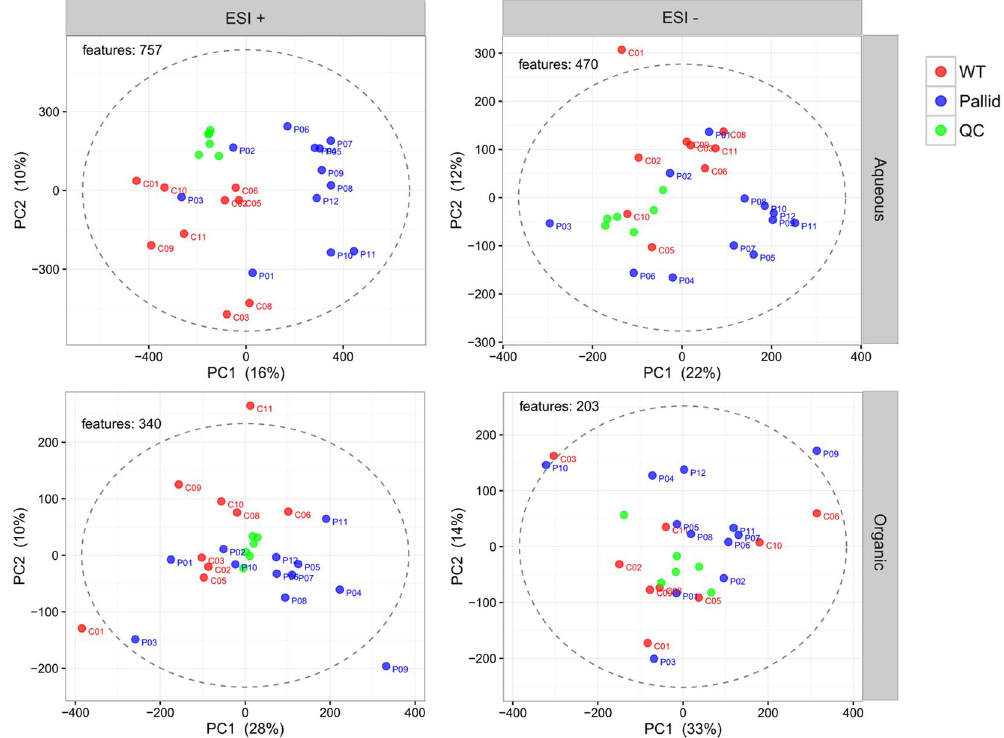
Figure 2. Principal component analysis (PCA) score plots representing the four different data sets. Sample scores for wild-type (WT) and pallid mice are indicated in red and blue, respectively, while the quality control (QC) samples are indicated in green. Scores are based on cleaned, QC-corrected, median-fold-change normalized, Pareto scaled and centered data. The number of features used per PCA, and the explained variance per component (PC1, PC2) are indicated in each panel. The Hotelling 95% confidence ellipses are represented by the dashed lines. ESI, electron spray ionization. Extraction phases are referred to as “Aqueous” and “Organic” as defined under